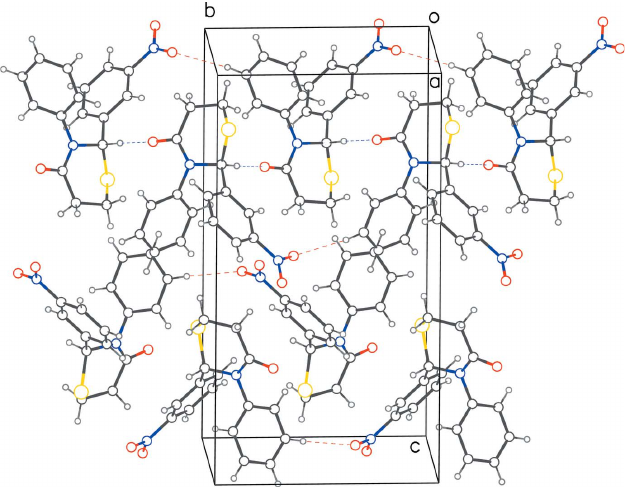
Figure 4 Packing diagram for 2 , showing the layering of molecules in the ab plane. Blue dotted lines show hydrogen bonds between molecules forming a chain in the b -axis direction and red dotted lines show a loop-back interaction within each